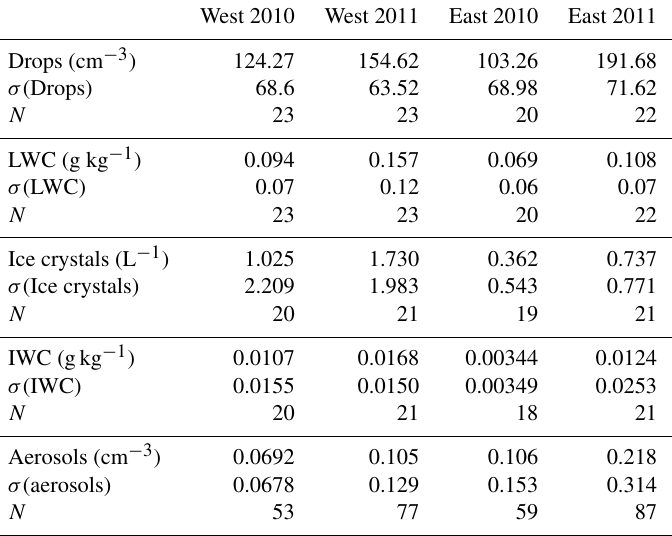
Table 1. Average values for cloud measurements and out-of-cloud aerosols for both years and both sides of the peninsula. σ ( x ) refers to the standard deviation of the variable x , and N the number of flight averages available for the global eastern or western averages. LWC refers to liquid water content, and IWC to ice water content.